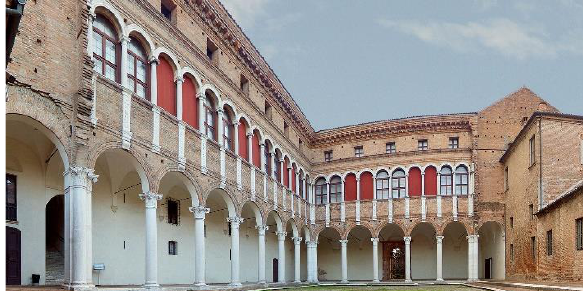
Figure 9. Palazzo Costabili internal courtyard. Northern and southern façades.